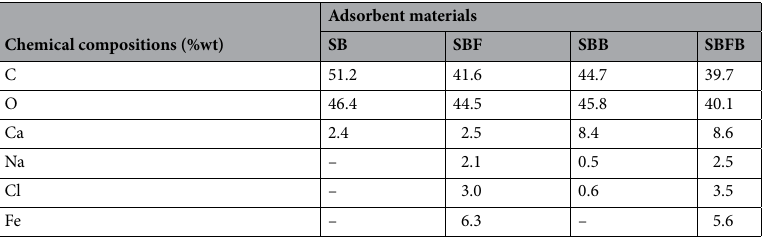
Table 2. The chemical compositions of sugarcane bagasse powder (SB), sugarcane bagasse powder doped iron(III) oxide-hydroxide (SBF), sugarcane bagasse powder beads (SBB), and sugarcane bagasse powder doped iron(III) oxide-hydroxide beads (SBFB) in the percentages by